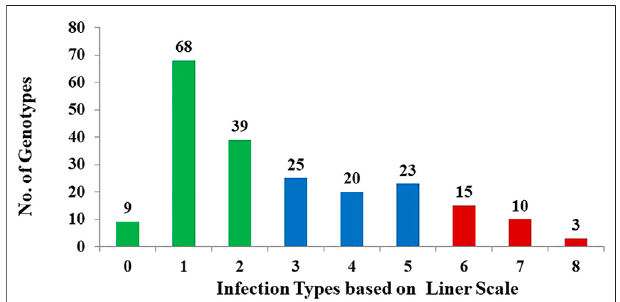
FIGURE 1 | Frequency distribution of stem rust severity scores For 212 randomly selected F 3:6 genotypes to infection with the common stem rust race in Nebraska, QFCSC using the linear scale. Green bars refer to the highly resistant genotypes, blue bars refer to moderate resistance, and red bars refer to susceptible